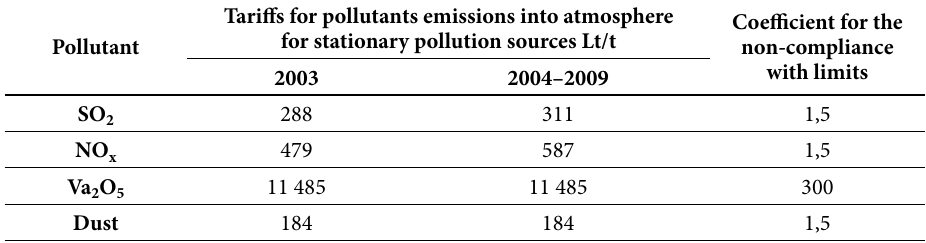
Table 1. Pollution taxes for emissions into atmosphere in Lithuania,